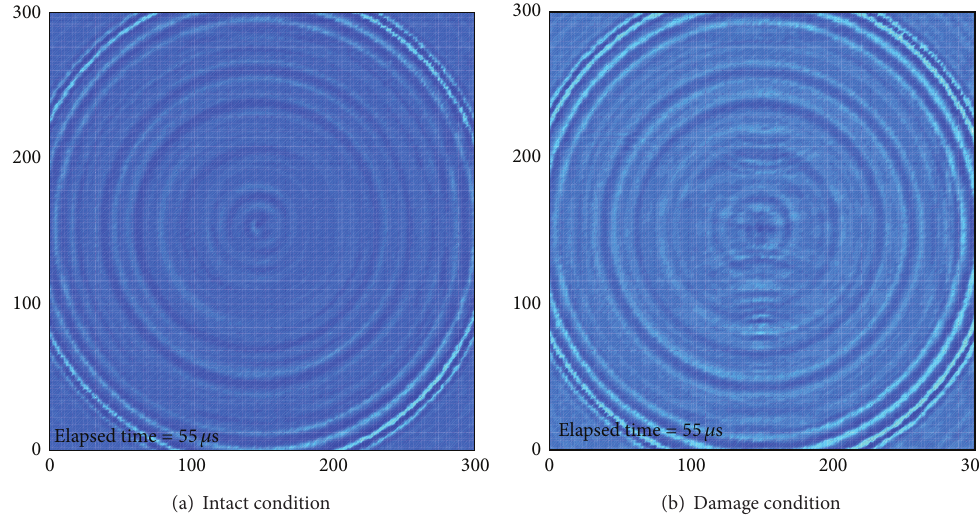
Figure 10: Comparison of UWPI snapshots at 55 𝜇